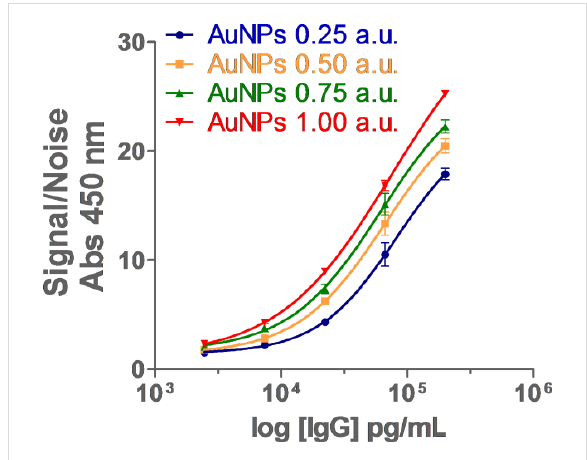
Figure 4: Optimization of AuNP probe concentration to be used in ELISA. Assayed concentrations: 0.25, 0.5, 0.75 and 1.00 Au. Results are normalized as S/N ratio which represents the absorbance at 450 nm of samples in the presence and absence of IgG,